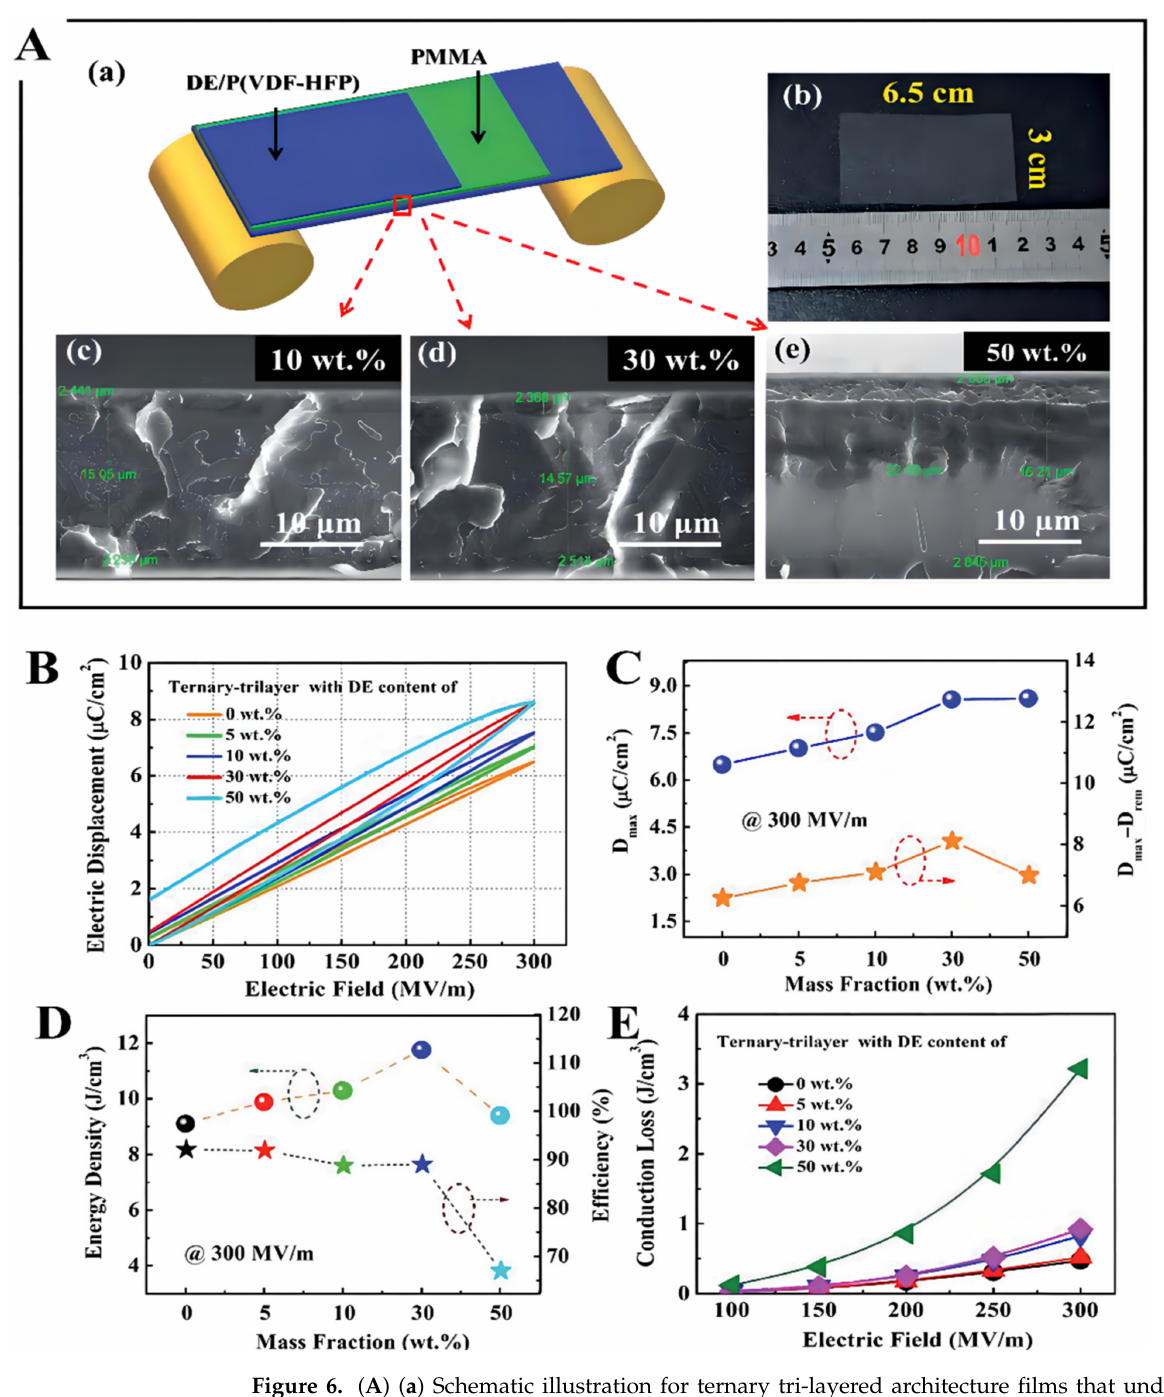
Figure 6. ( A ) ( a ) Schematic illustration for ternary tri-layered architecture films that underwent the layer-by-layer solution casting method. ( b ) Sample photo image of the ternary tri-layered ar- chitecture film with 30 wt.% DE and ( c – e ) cross-sectional SEM morphologies of ternary tri-layered architecture films with 10 wt.%, 30 wt.%, and 50 wt.% DE films under high magnification, respectively. ( B ) Unipolar electric displacement–electric field (D–E) loops. The typical electric displacement–electric field (D–E) loops of the ternary tri-layered architecture membranes are measured with a 10-Hz unipo- lar triangle signal as a function of the applied field. ( C ) Maximum and electric displacement difference measured at 300 MV m − 1 and 10 Hz. ( D ) Discharged energy density and efficiency measured at 300 MV m − 1 . ( E ) Conduction loss at varied electric fields of the ternary tri-layered films at different DE loadings. Adapted with permission from [36], Copyright © 2022 Royal Society of